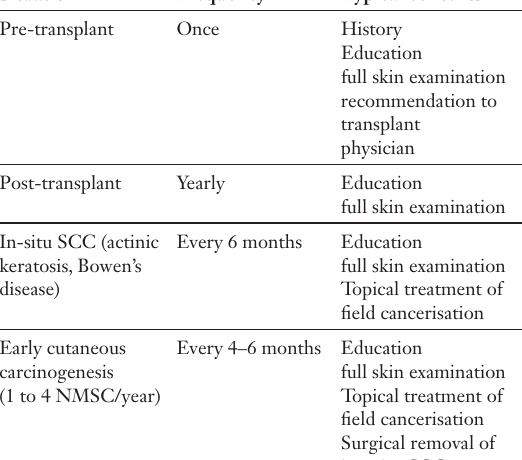
Recommended der- matological consulta- tions in SOTR. In all situations: Exchange informa- tion and discuss management with transplant team and primary physician in charge of the trans- plant